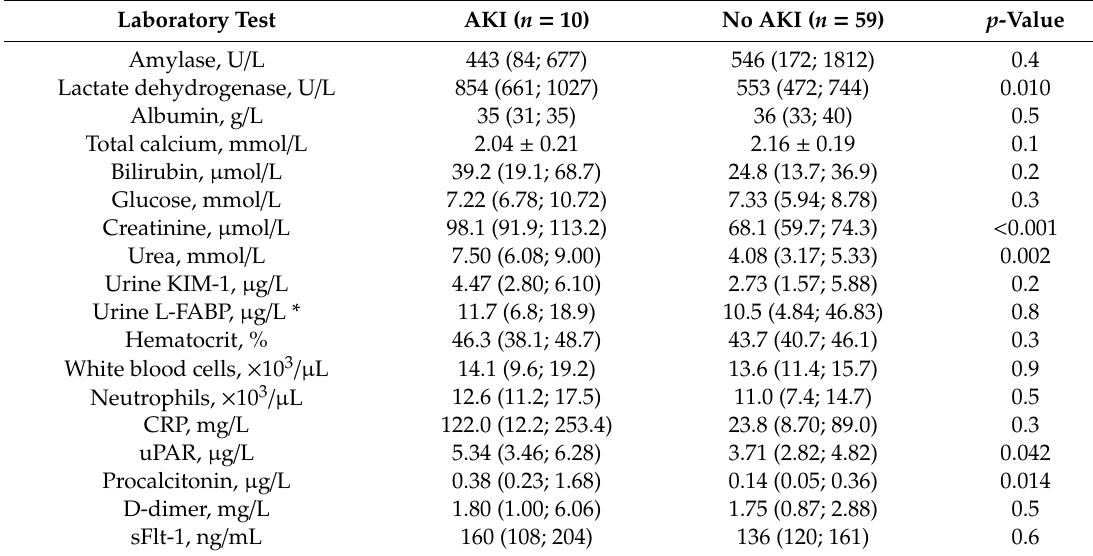
Table 2. The results of laboratory test performed in the studied patients with acute pancreatitis on the day of admission. Data are shown as median (lower; upper